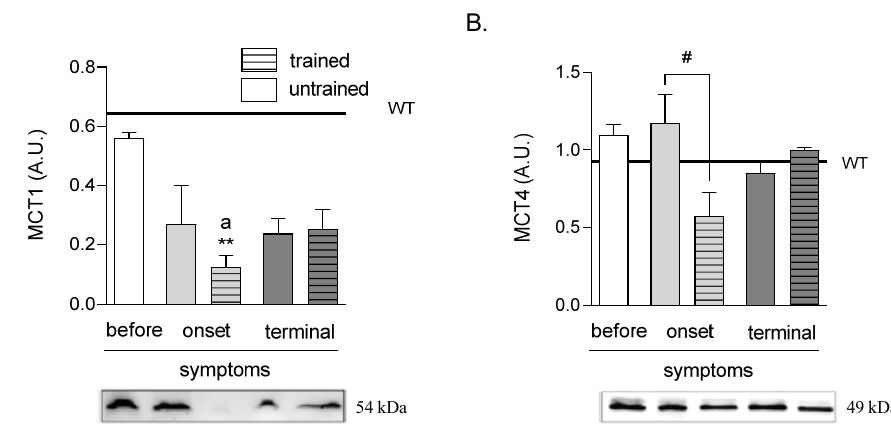
Figure 4. Effects of ALS disease progression and swim training on skeletal muscle MCT1 and MCT4 protein levels. MCT1 ( A ) and MCT4 ( B ) protein levels were measured in the tibialis anterior muscle of mice. There were significant differences between the groups: ** p < 0.01 vs. WT group of mice, a p < 0.05 vs. BEFORE group (Tukey’s post-hoc test), # p < 0.05 between indicated group (Stu ‐ dent’s t ‐ test). The data are presented as the means ± SEM ( n = 3 in each group).